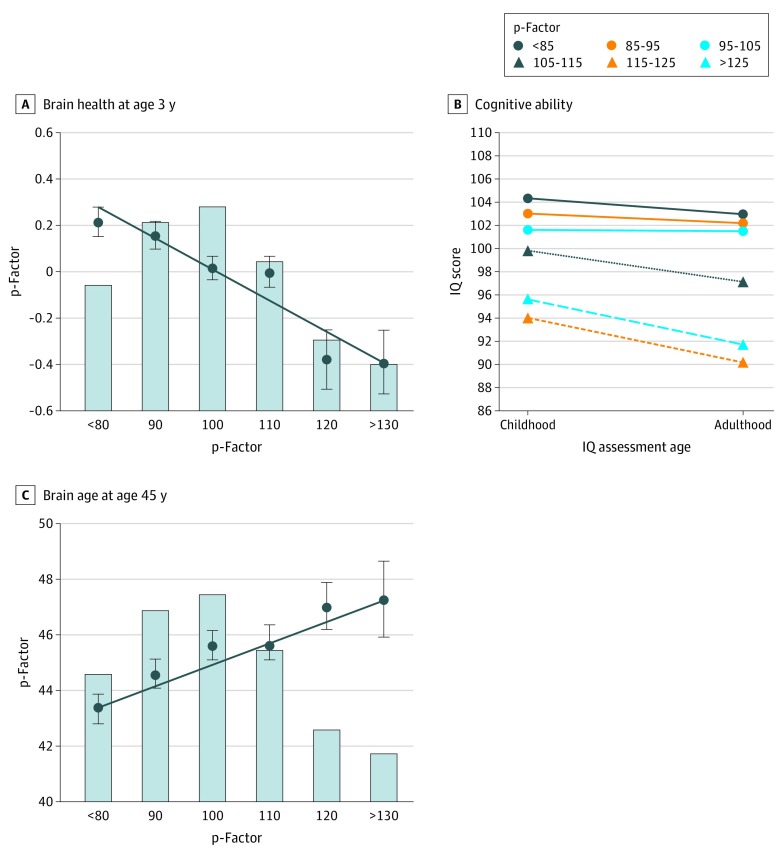
Origins and Sequelae of the p-FactorGraphs show that compromised brain health at age 3 years was associated with higher p-factor scores (A) and that higher p-factor scores were associated with more decline in cognitive ability from childhood to adulthood (B) and older brain age by midlife (C). In each panel, the p-factor score is standardized to a mean (SD) of 100 (15), and higher p-factor scores indicate more generalized psychopathology. In A and C, the bars of the histograms graph the proportions of the sample at different levels of the p-factor score (midpoint of 10-point bands): less than 85 (163 participants [16.3%]), 85 to 95 (237 participants [23.7%]), 95 to 105 (259 participants [25.9%]), 105 to 115 (189 participants [18.9%]), 115 to 125 (91 participants [9.1%]), and greater than 125 (61 participants [6.1%]). The circles and SE bars show the mean scores of individuals in each p-factor score group; these groups have been clumped solely for graphing purposes (with group size >50). The regression lines in A and C show the association between the p-factor score and its childhood correlates and adult sequelae. The regression coefficients reported in the text are based on the full distribution of p-factor scores (see eAppendix 11 in the Supplement for scatterplots).